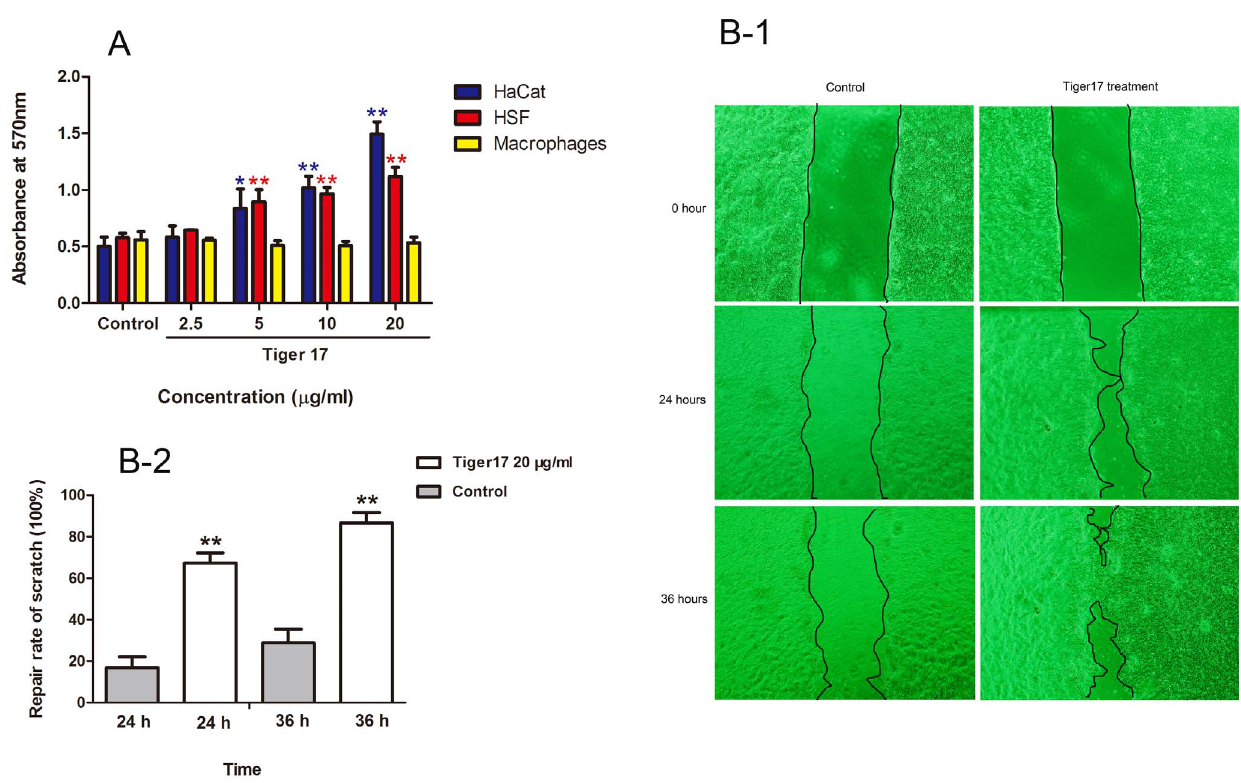
Figure 1. Tiger17 promotes HaCat cells proliferation and migration. (A) Keratinocytes, fibroblasts or macrophages (2 6 10 4 cells/ml) were separately cultured in wells of 96-well plate, and cells were incubated with various concentration tiger17 (2.5, 5, 10, 20 m g/ml) or sterile H 2 O alone for 24 h. After incubation with 5 mg/ml MTT for 4 h, absorbance was determined. It was very obviously that both HaCat keratinocytes and HSFs were increased by tiger17 treated, in a concentration dependent manner. Tiger17 had little effect on macrophages proliferation. Values are the mean 6 SE of three independent experiments. *P , 0.05, **P , 0.01 as compared between tiger17-stimulated and non-stimulated cells. (B) HaCat keratinocytes cells (1 6 10 6 cells/ml) were cultured in wells of 6-well plate; cells were scratched and incubated with tiger17 (20 m g/ml) or vehicle. (B-1) Cells migration was recorded by photomicrograph at post-scratched 0 hour, 24th hour and 36th hour. The black line denoted the margin of gap. (B-2) The repair rate of scarification was calculated by Image J. According to the formula, repair rate of scarification %=(the gap width of 0 hour - temporal gap width)/the gap width of 0 hour 6 100%. Scarification width was measured in triplicates wells. The distance of matched 6 pairs of points was separately measured in each well for averaging the gap width. Values are the mean 6 SE of three independent experiments. **P , 0.01 as compared between Tiger17-treated and untreated cells.